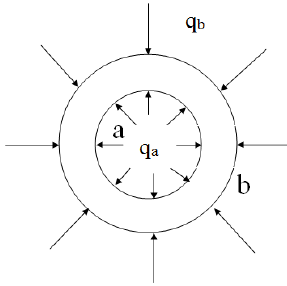
Figure 7. Sketch to illustrate Lame’s